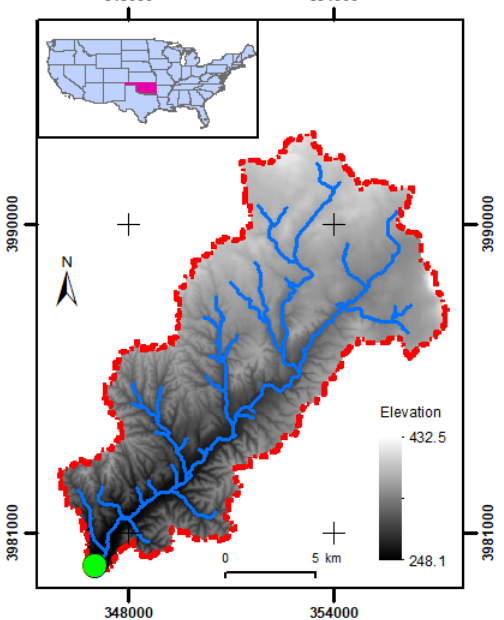
Figure 1. Case study. Basin location, elevation and drainage network.